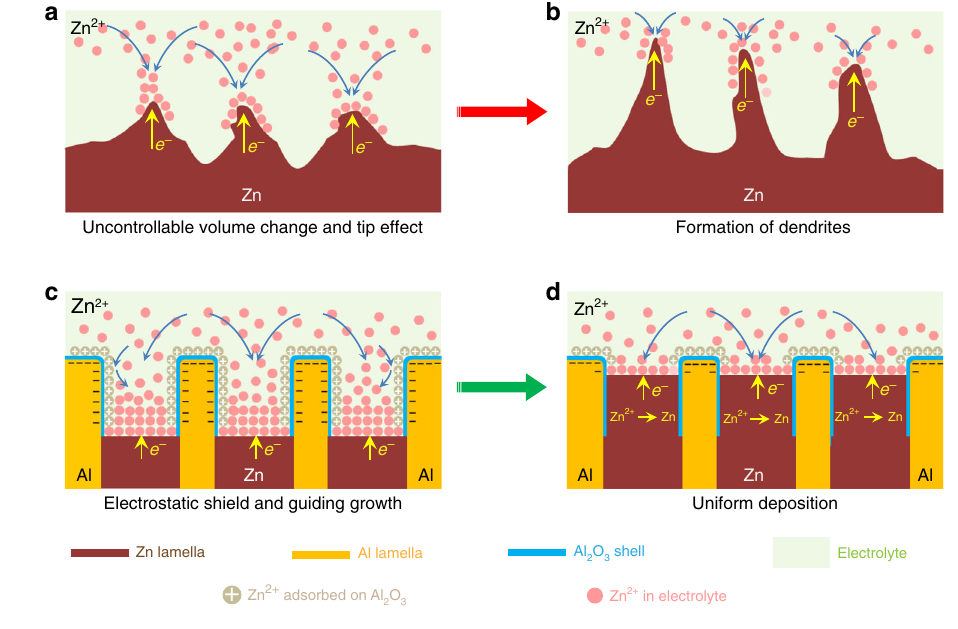
Fig. 1 Schematic illustration of eutectic strategy for dendrite and crack suppression. a Monometallic Zn electrodes with abundant cracks or defects that are produced by uncontrollable volume change in the Zn stripping/plating processes. b Growth of Zn dendrites triggered by uncontrollable volume change and tip effect. c Eutectic Zn/Al alloys with a lamellar structure composed of alternative Zn and Al nanolamellas in-situ produce core/shell interlayer patterns during the Zn stripping to guide the subsequent Zn plating. d The Al/Al 2 O 3 interlayer patterns associated with insulative Al 2 O 3 shield facilitate the uniform deposition of